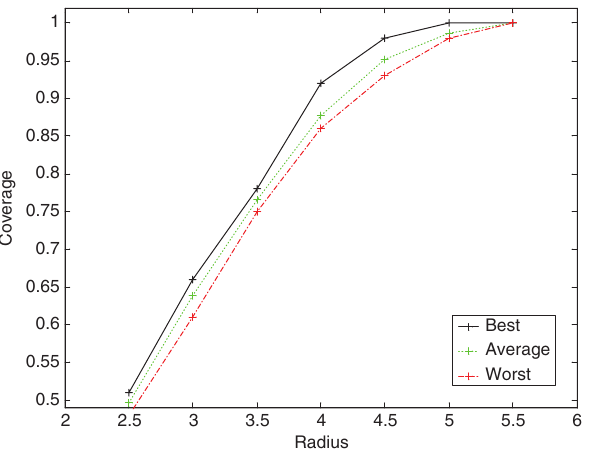
Figure 9: The Line Chart of the Coverage Rate with the Node Sensing Radius Changing.